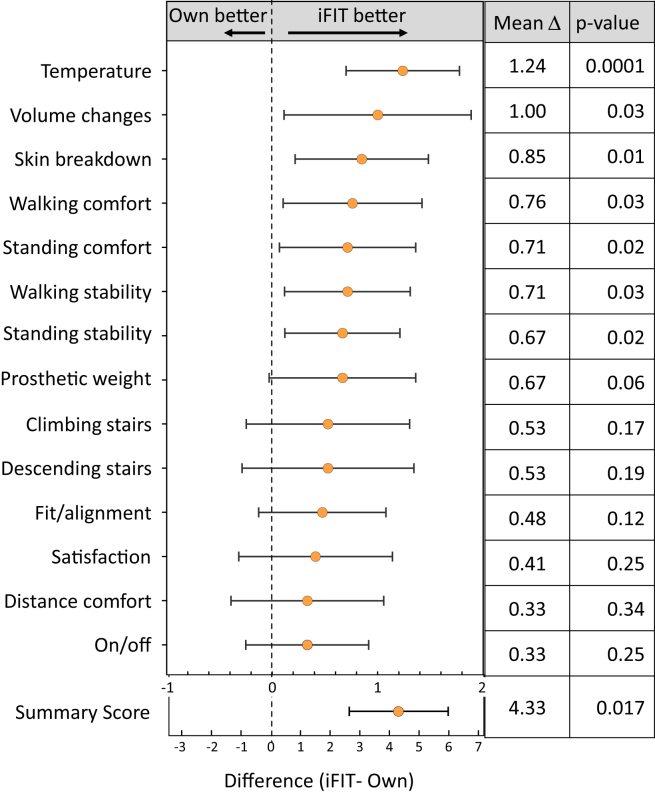
Average difference between iFIT and conventional prosthesis according to PEQ-based questionnaire data based on the 21 participants completing the study who had conventional devices prior to using the adjustable test prosthesis.